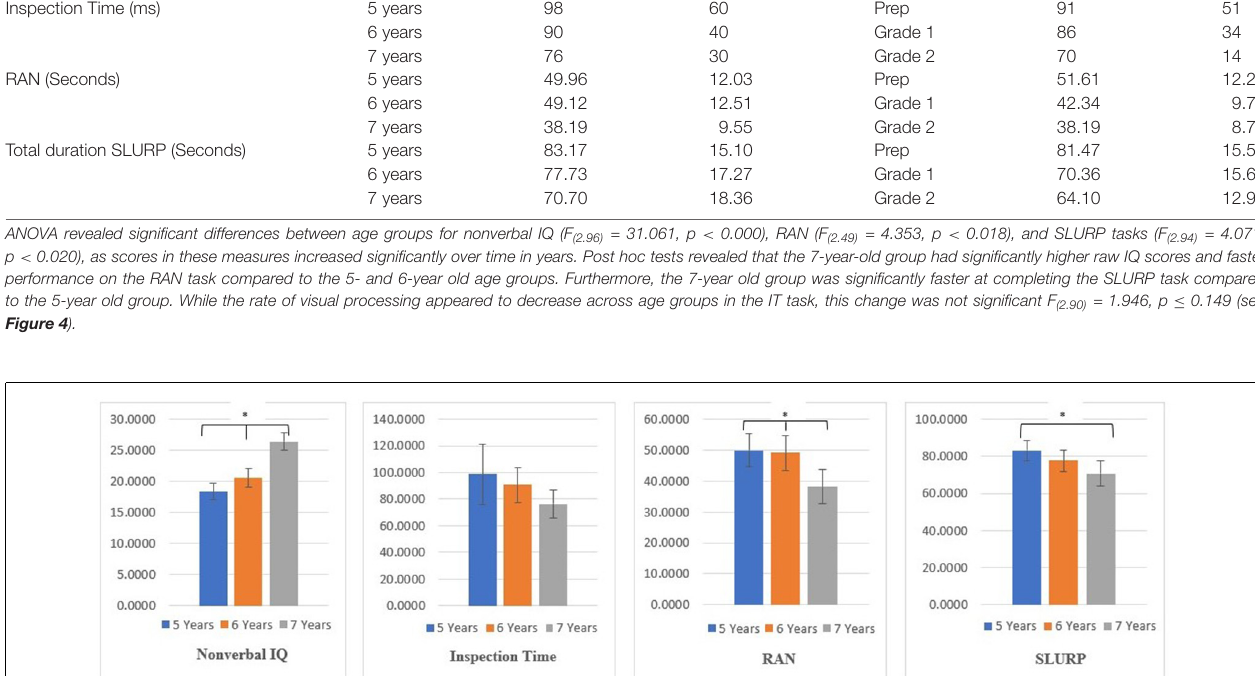
TABLE 3 | Descriptive statistics for visual, visual/verbal, and visuomotor processing by age and grade. Nonverbal IQ (raw scores)